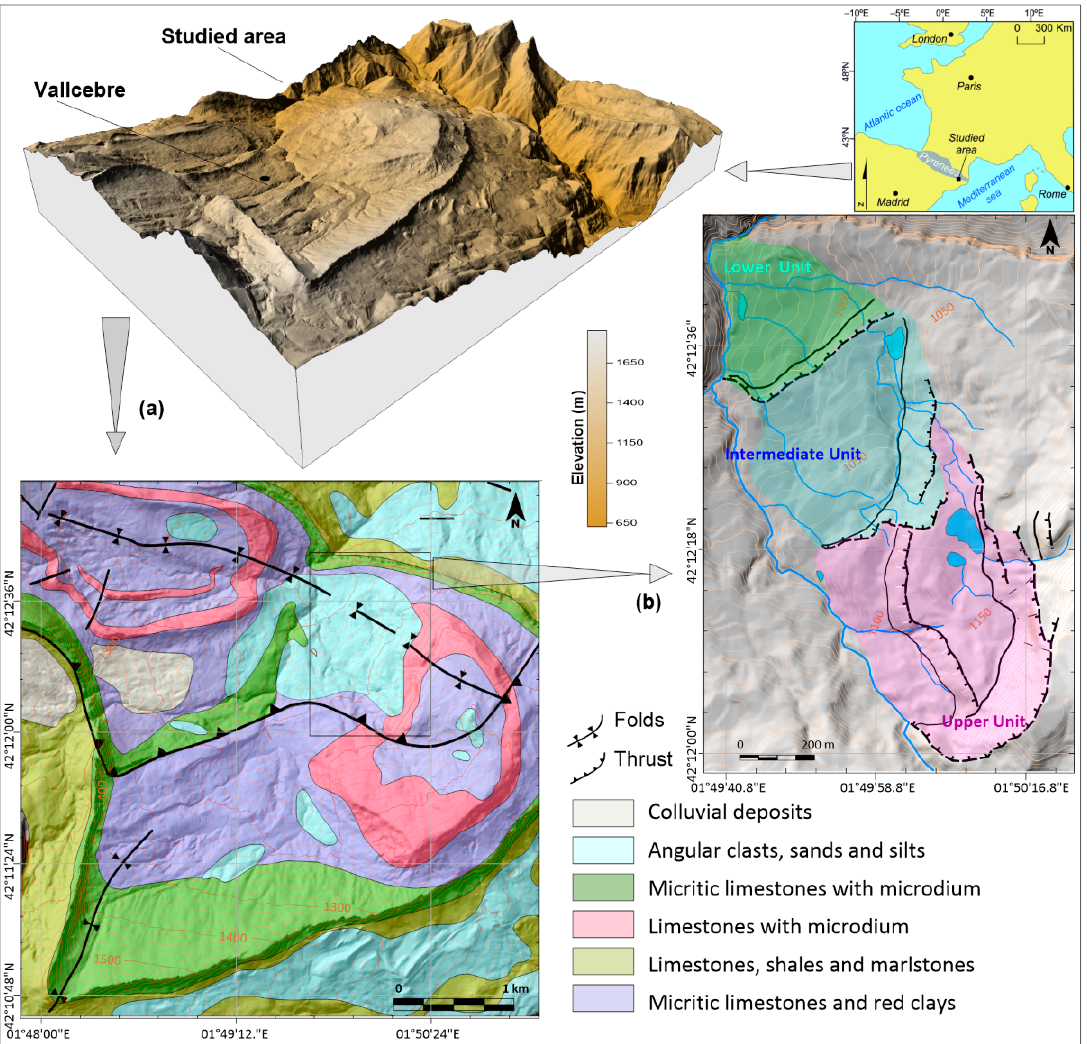
Figure 1. ( a ) Location sketch and geological map of the studied zone. Modified from [25]; ( b ) Geo- morphological sketch (modified from [21]) and digital elevation model of the Vallcebre landslide obtained using LIDAR data from Catalan Geological Survey [26].